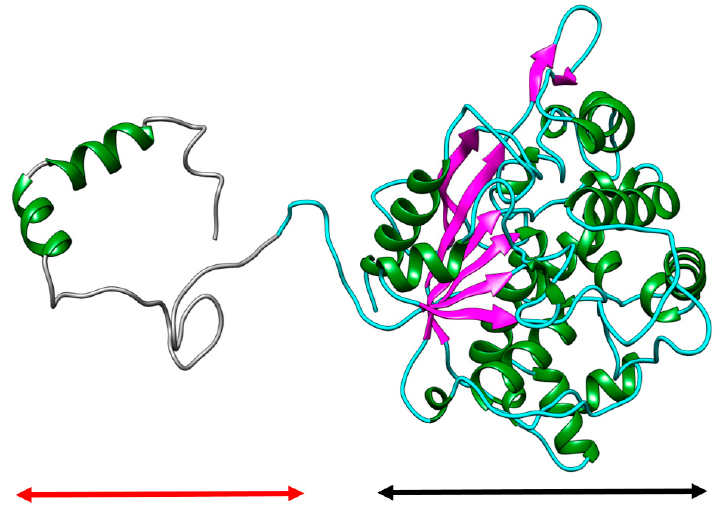
Figure 1. The preliminary structure of AMS3 lipase model built with Raptor X. The secondary structure indicated by the red arrow shows GST C Pseudomonas sp. form in α helix and coils. The lipase domain is indicated by black arrow. The GST C Pseudomonas sp. contains 57 amino acid. Magenta: β -sheet; Green: α -helix; Cyan: coil; Grey: GST-C Pseudomonas sp. AMS3.